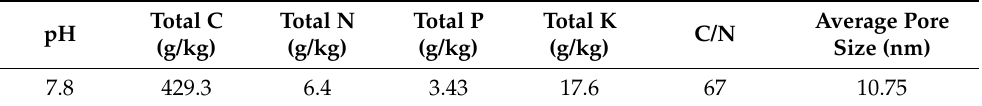
Table 3. Basic properties of maize straw in field